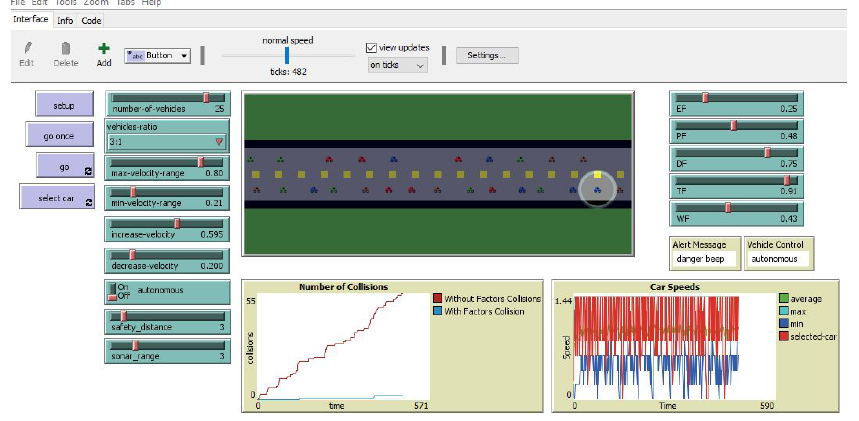
Figure 11. Main Simulation Interface and Control Shifted to AV.